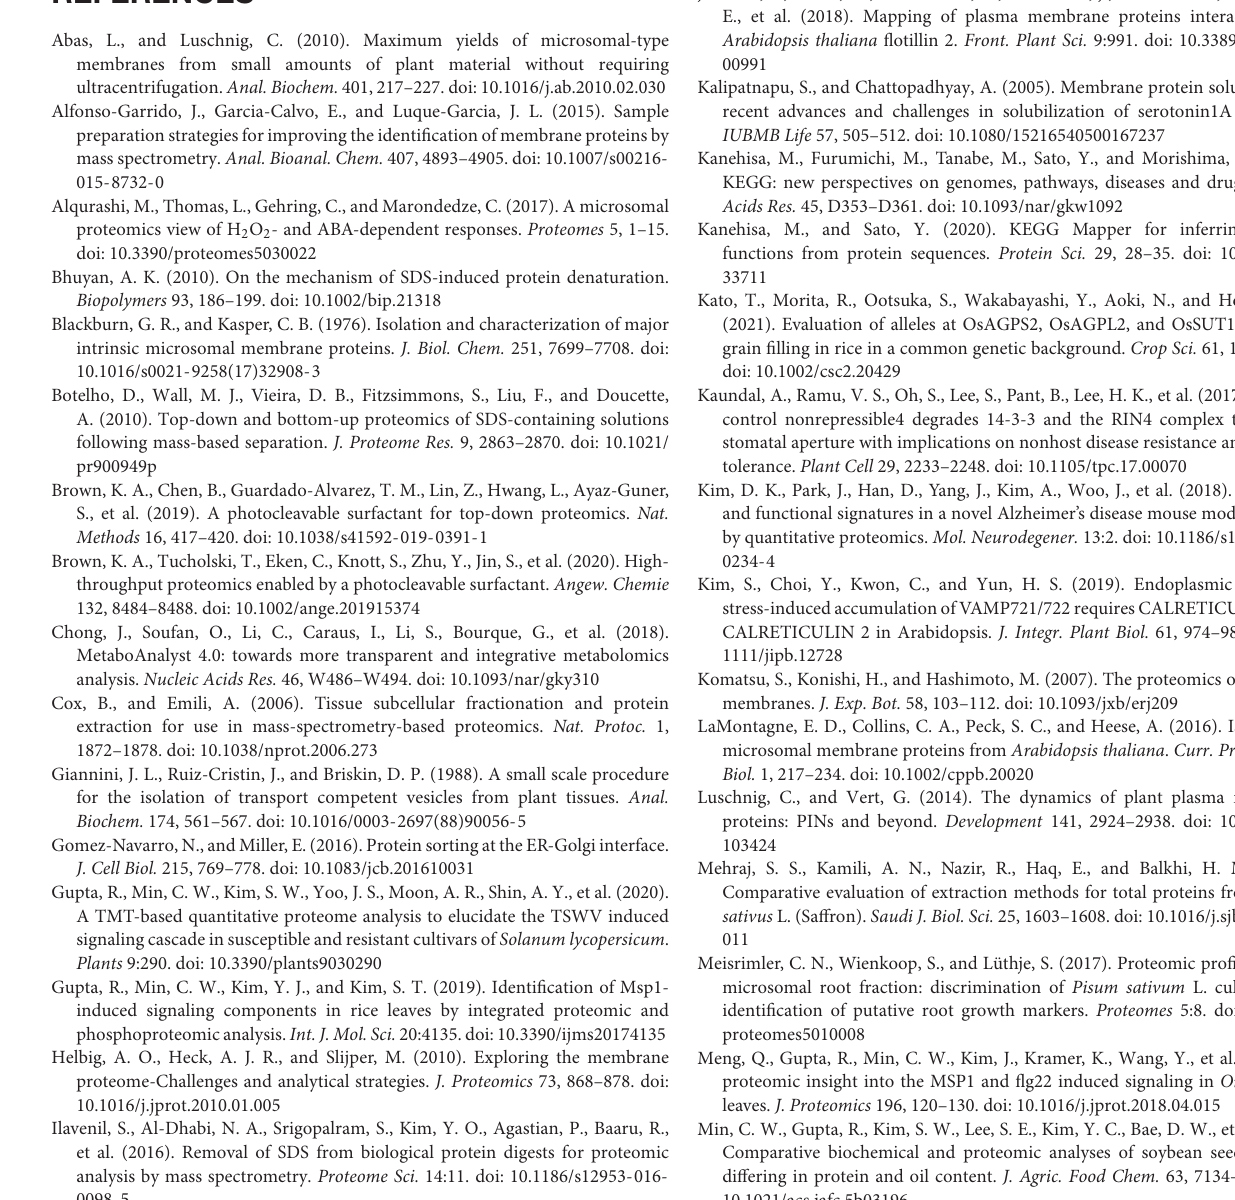
Supplementary Table 2 | Identification of differentially modulated proteins by comparison between two different microsomal protein extraction methods. Supplementary Table 3 | Gene ontology (GO) enrichment analysis of differentially modulated proteins by comparison between two different microsomal protein extraction methods. Supplementary Table 4 | List of identified KEGG brite using differentially modulated proteins by comparison between two different microsomal protein extraction methods. Supplementary Table 5 | KEGG pathway analysis of differentially modulated proteins by comparison between two different microsomal protein extraction methods using the KEGG brite database.